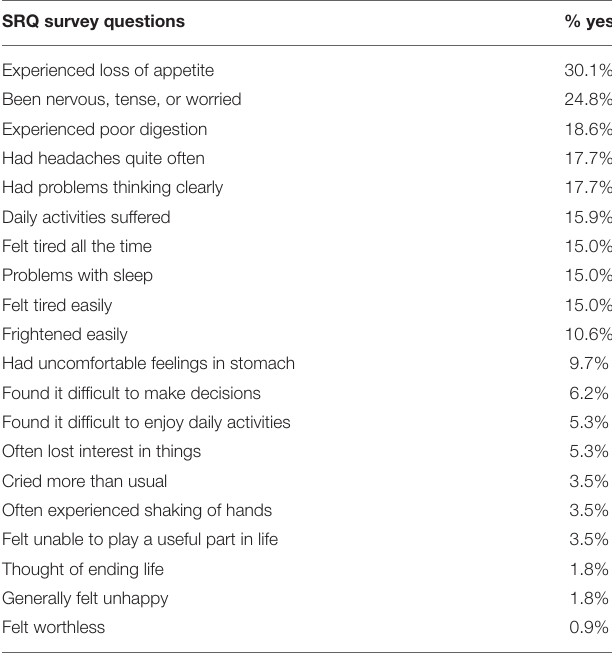
TABLE 1 | Proportions of women who answered Self Reporting Questionnaire questions